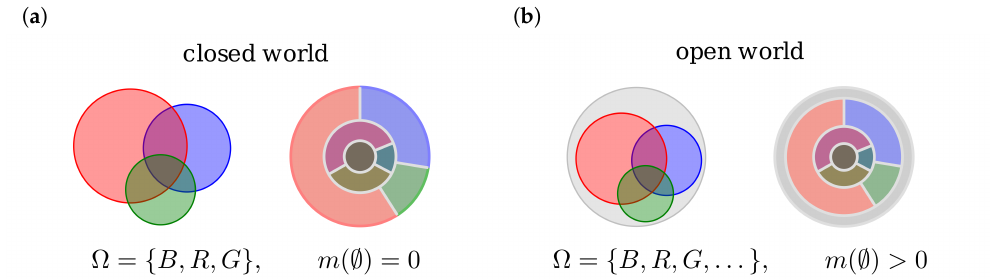
Figure 2. Closed world vs. open world assumption: ( a ) In a closed world no mass is given to the empty set, thus no outcome beyond Ω is possible. ( b ) In an open world a basic belief mass is given to the empty set allowing the ability to consider completely unexpected events to the model (e.g., broken coin) or to deal with data of low